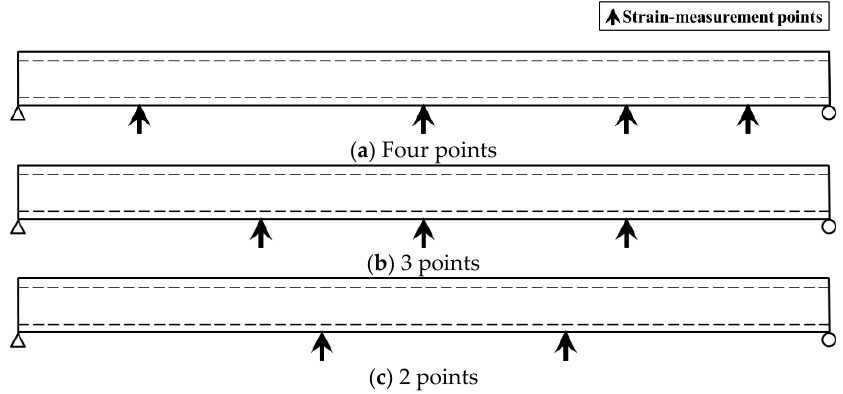
Figure 6. The optimized locations of strain-measurement points.